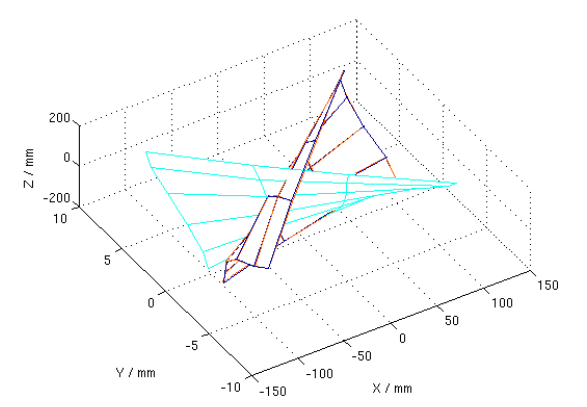
Figure 6. In red, the surface after deformation and correction of the exterior orientation of one image using the proposed method based on a shape function; In dark blue, the deformed surface reconstructed using the traditional method; In cyan, the surface before deformation given by iWitness